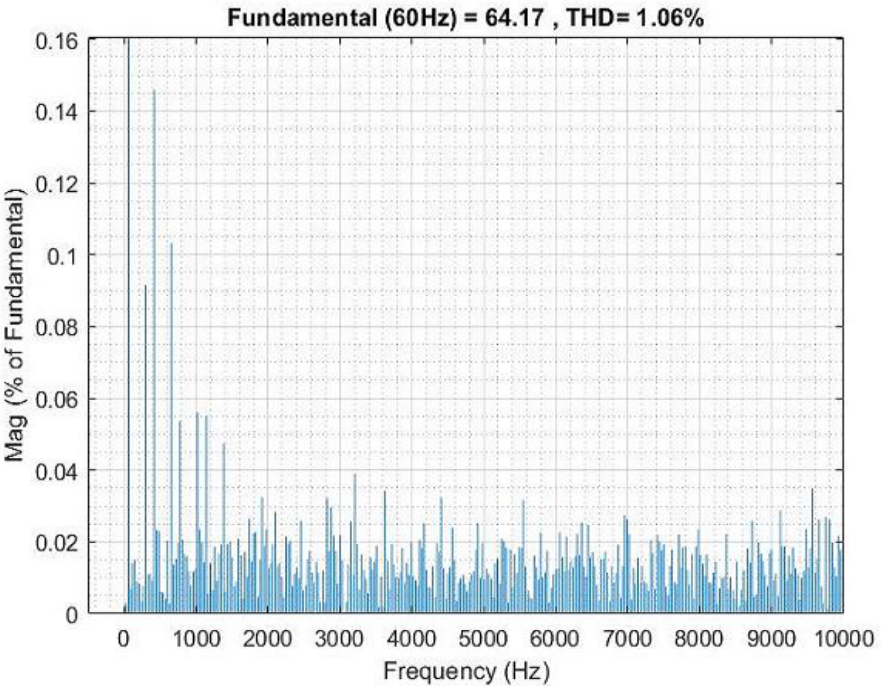
Figure 16. %THD of current for the two-step horizon prediction for parallel-connected DGs in grid- connected